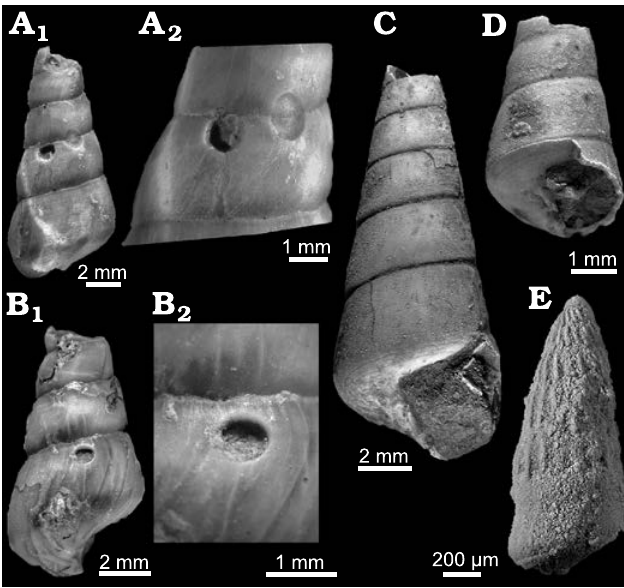
Fig. 16. Protorculid gastropods from Lago Antorno (A–D) and Misurina Landslide (E), northern Italy, Cassian Formation, Carnian, Upper Trias sic. A . Atorcula sp., PZO 12816, in lateral view with drill holes (A 1 ), A 2 , close up showing incomplete drill hole (right) and complete one (left). B . Atorcula sp., PZO 12817, in lateral view (B 1 ), B 2 , close up showing drill hole. C . Atorcula canalifera (Münster, 1841), PZO 12819, in apertural view. D . Atorcula cana- lifera (Münster, 1841), PZO 12888, in apertural view. E . Atorcula canalifera (Münster, 1841), PZO 12697, axially ribbed larval shell and first smooth teleoconch whorls, in lateral